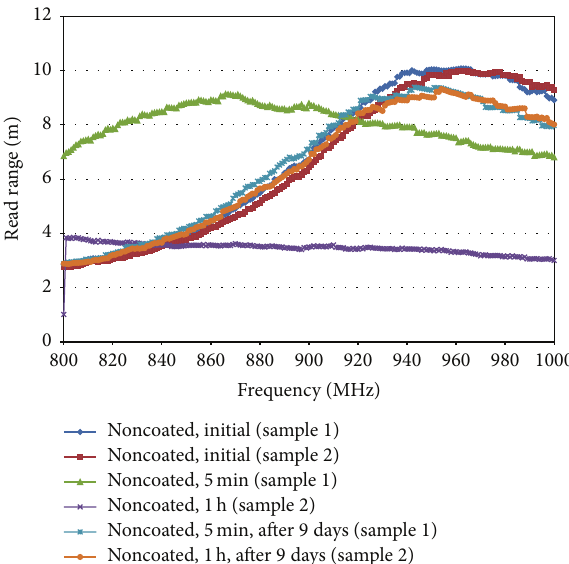
Figure 3: Measurement results for noncoated sensor tags.